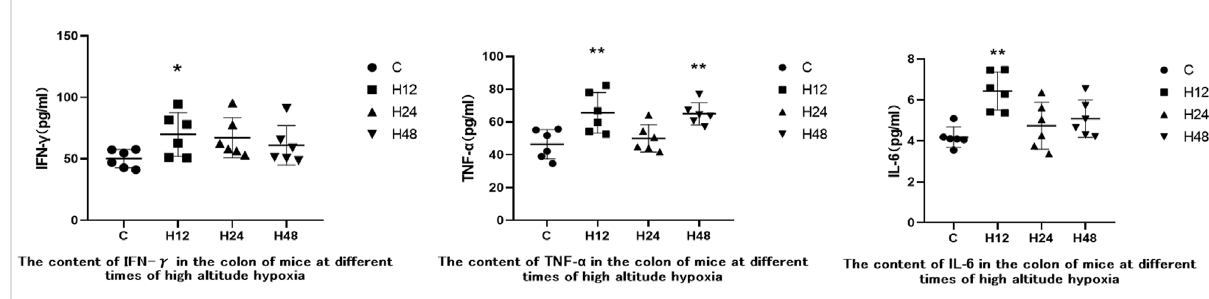
FIGURE 4 Expression of in fl ammatory factors in colon tissues of each experimental group. 1: C, control group; 2: H12 group, the high-altitude group for 12 h;3:H24group,high-altitudegroupfor24 h;H48,high-altitudegroupfor48 h, n